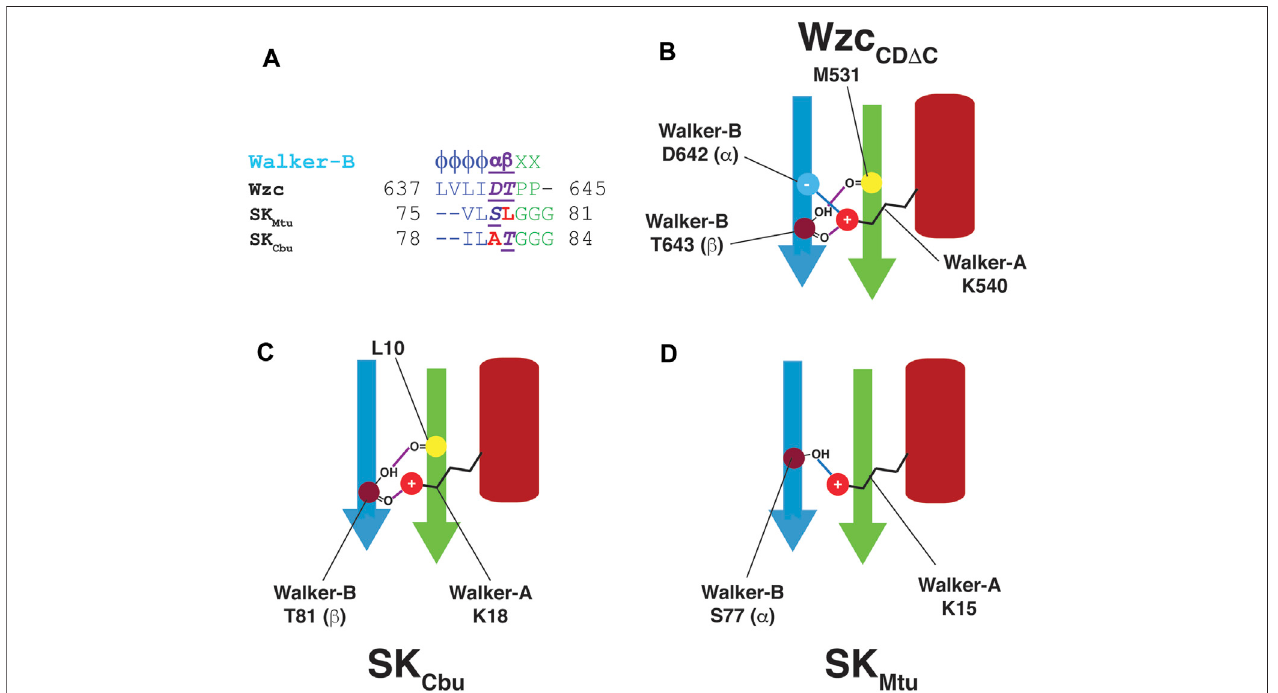
FIGURE 4 | (A) Comparison of the Walker-B sequences in Wzc, SK Mtu and SK Cbu . Wzc contains polar residues at both the α − and β − positions while only one of these positions is polar in SK Cbu ( β ) and SK Mtu ( α ) (B) The presence of polar residues at both the α − (D642) and β − positions (T643) in the Walker-B motif of Wzc CD Δ C allowstheintricatenetworkofinteractions toappropriately aligntheWalker-ALys(K540)leadingtoitswell-de fi nedorientation intheOS.Theseinteractions aredepicted schematically; hydrogen-bonds are indicated using purple and blue lines. Since only one of the α − or β − positions contain a polar residue in (C) SK Cbu ( β :T81) and (D) SK Mtu ( α :S77), only oneofthese sets ofinteractions(blueor purple) ispreserved allowing agreaterdegree oforientational freedom in theWOS forthecorresponding Walker-A Lys (K18 in SK Cbu , K15 in SK Mtu